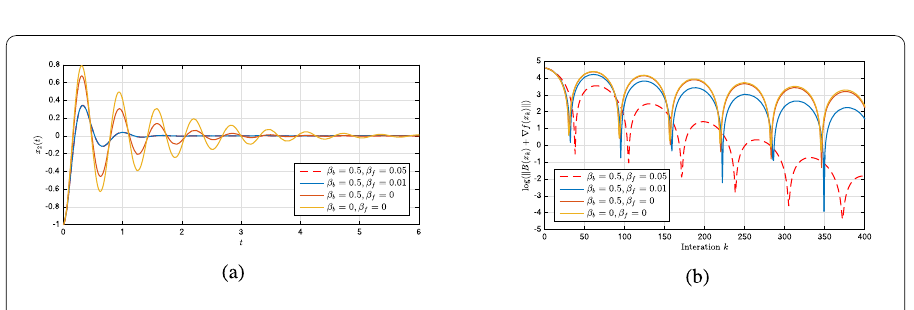
Figure 2 Oscillation of the trajectories of (DINAM) for different values of β b , β